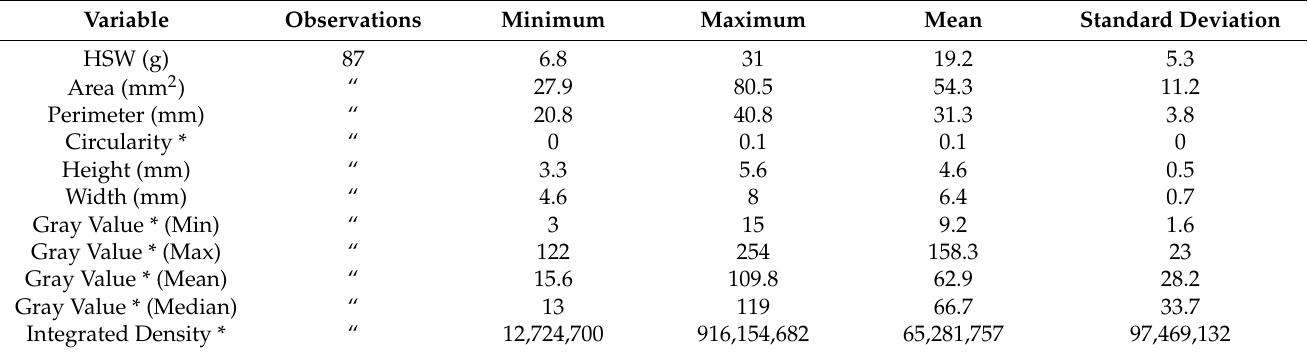
Table 1. Summary statistics of the seed morphological